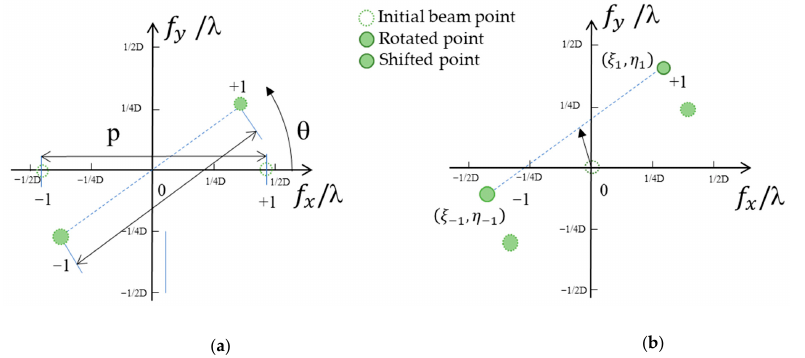
Figure 6. CGH calculation algorithm for beam steering with two points. ( a ) Clockwise rotation. ( b ) Linear shift along the x- and y-directions. The experimental results of two-point beam steering by rotation and the linear shift along the x- and y-directions are depicted in Figure 7a,b, and c respectively.